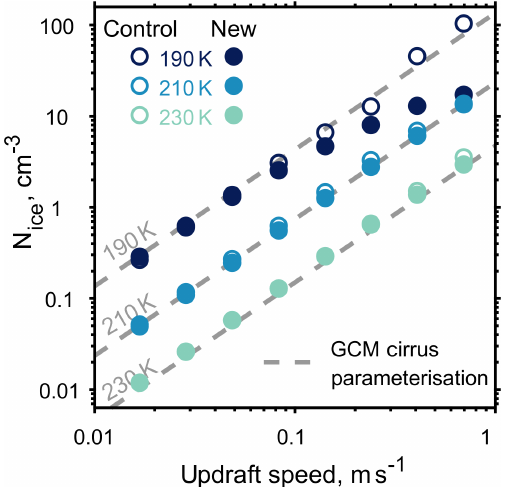
Figure 8. The effect of updraft speed and temperature on the for- mation of ice for both the new and control cloud parcel models is shown by the filled and outlined circles respectively. The grey dashed line represents a parameterisation for ice number density in cirrus clouds used in a large-scale general circulation model (Kärcher and Lohmann,